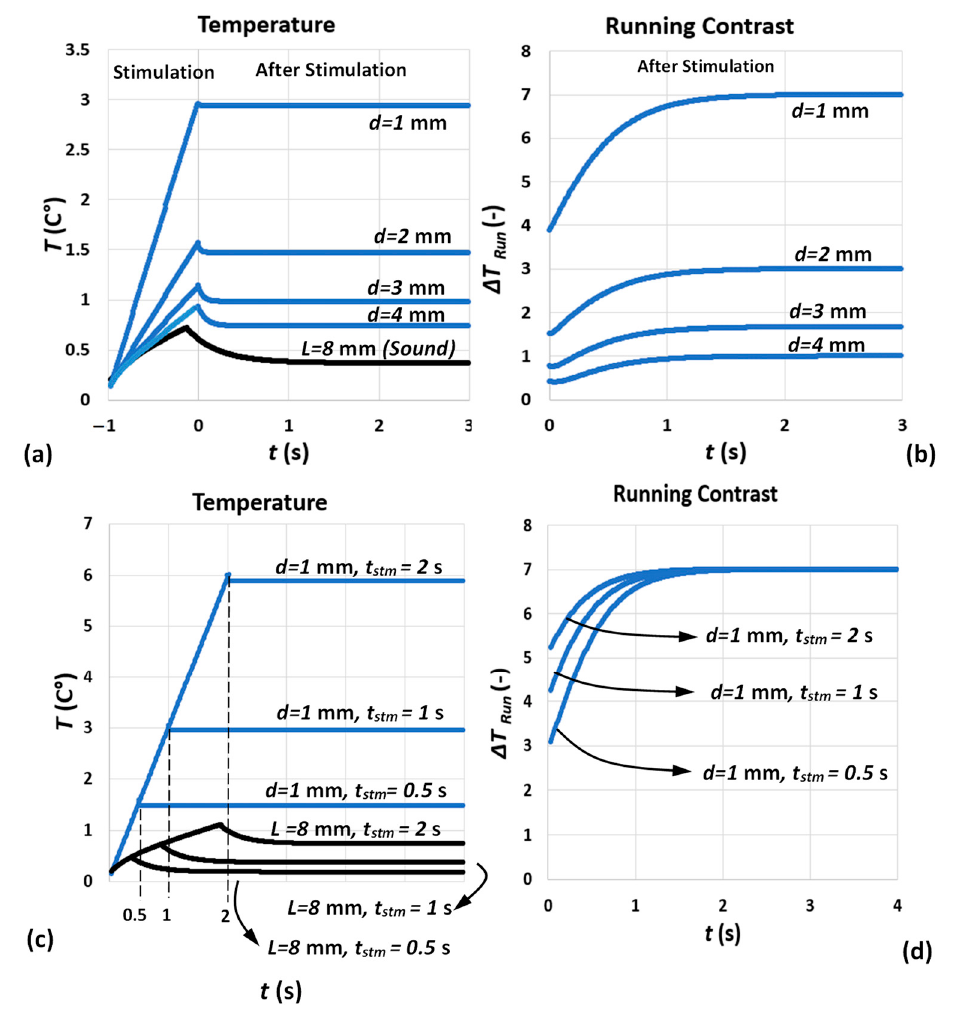
Figure 7. ( a , b ) 1D temperature and running temperature contrast defects with diameter D = 22 mm and various depths, d , on an L = 8 mm thickness mild steel specimen subjected to a square-pulse stimulation of duration t stm = 1 s. ( c , d ) 1D temperature and running temperature contrast of a defect with diameter D = 22 mm and d = 1 mm on an L = 8 mm thickness mild steel sample subjected to square-pulse stimulation of duration t stm = 0.5, 1 and 2 s. The pulse absorbed power density is assumed Q = 10 kW/m 2